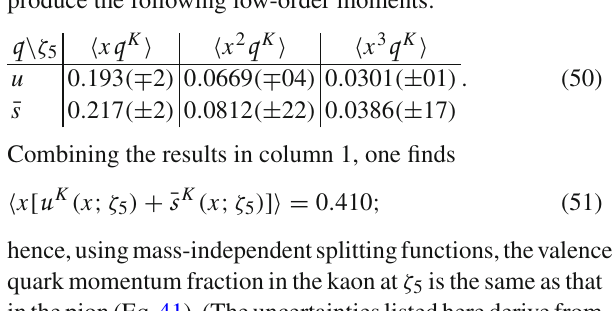
Fig. 9 Kaon DFs, defined at ζ H by Eqs.(12), (45) and Table 3, evolved → ζ = u ; and dot-dashed green curve ζ H 5 : solid blue curve – q – q = ¯ s . The like-coloured bands surrounding each curve mark the domain between the “upper” and “lower” results from Table 3: “lower” produces the curve with greatest magnitude in the peak region and smallest magnitude at large x Table 4 Coefficients and powers that provide interpolations for the computed kaon valence-quark distribution functions, depicted in Fig.9, when used in Eq.(33): Rows 1–3 – u -quark; and Rows 4–6 – ¯ s